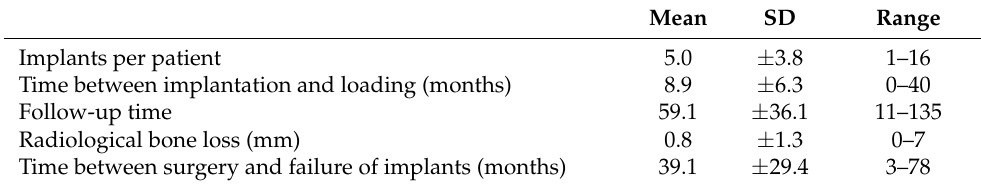
Table 6. Implant outcome at time of